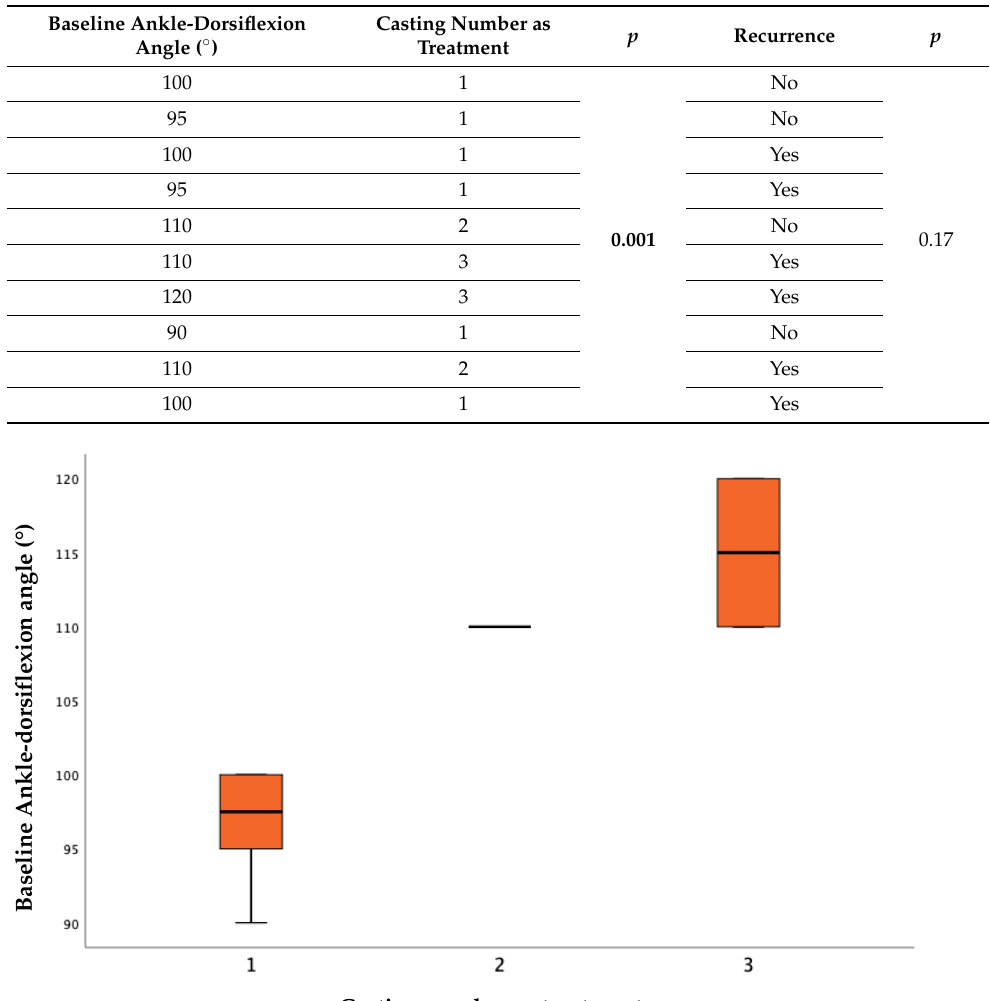
Figure 2. Casting number as treatment and baseline ankle-dorsiflexion angle (°), p = 0.001. No statistically significant difference after protocol treatment was detected in the GARS-3 scores usign Wilcoxon signed ranks test (maean and standard deviation pre- and post-treatment, 48.11 ± 14.35 versus 49.11 ± 13.03, respectevely, with p = 0.66). 4. Discussion The ASD child is a real challenge for the doctor. He has different symptomatologic expressions, not only from the behavioral but also from the postural and psychomotor point of view. According to the DSM-V, the Social Communication and Interaction are really important features. Indeed, Barsotti J. et al. [29] identified specific receptive grammatical deficits that could be or not related to expressive deficits. Toe walking is a bilateral gait abnormality in which a normal heel strike is absent and most weight bearing occurs through the forefoot. The normal sequence of development of walking does not include walking on toes and generally proceeds gradually to a heel- toe pattern, with a heel-strike present at 18 months and a heel-to-toe gait achieved by age 3 [30]. Sometimes this process is compromised with the persistence of toe walking during the growth, as in the ASD child. W.J. Barrow et al. [31] confirmed the high incidence of toe walking in ASD and with language disorders and also raised the possibility of a sec- ondary orthopedic deformity that can complicate long-term management of these pa- tients. The largest study in the literature [32] on Patient Record Database (2,221,009 pedi- atric patients) revealed 8% of ASD children had toe-walking. These study showed that typically developing children have higher rates of toe-walking resolution without treat- ment than children with ASD, and therefore the latter require more attention from the doctor. In addition, important correlations between ASD and musculoskeletal disorders have been studied. Ludyga et al. [33] demonstrated ASD children had impairments in executive function and muscle strength compared to healthy peers. Higher muscle strength was independently associated with better executive function but only in ASD patients. The promotion of muscle strength, for example, by regular exercise, could con- tribute to a reduction of ASD-related executive dysfunction. Stins et al. [34] reviewed mo- tor abnormalities, such as poor timing and coordination of balance could affect children with ASD. Furthermore, other muscular diseases in young children with ASD, such as